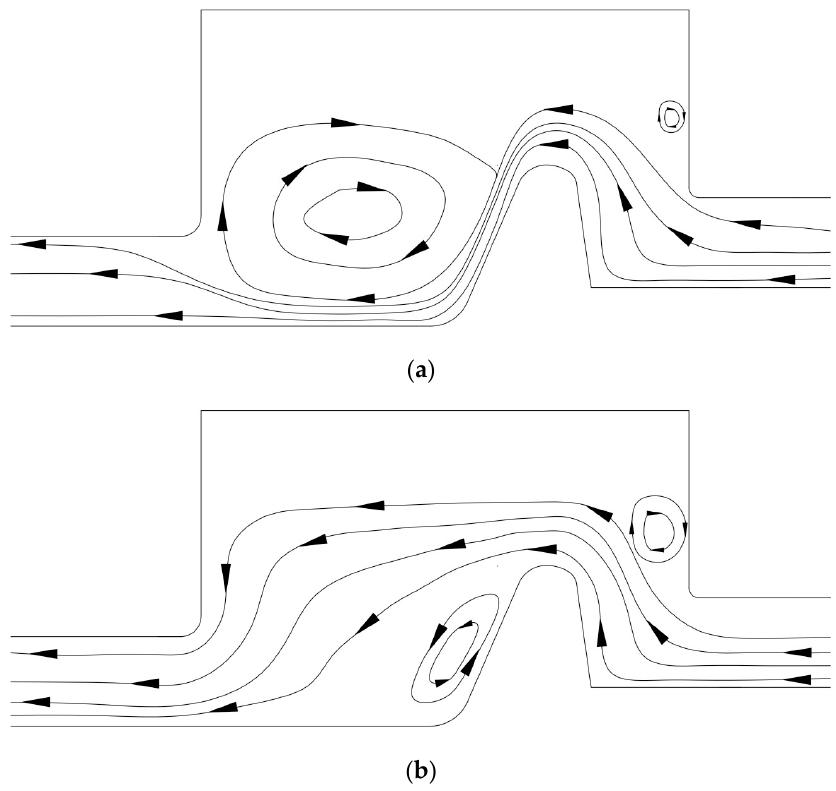
Figure 9. Streamline for two sloshing regions. ( a ) For region 1; ( b ) For region 2.